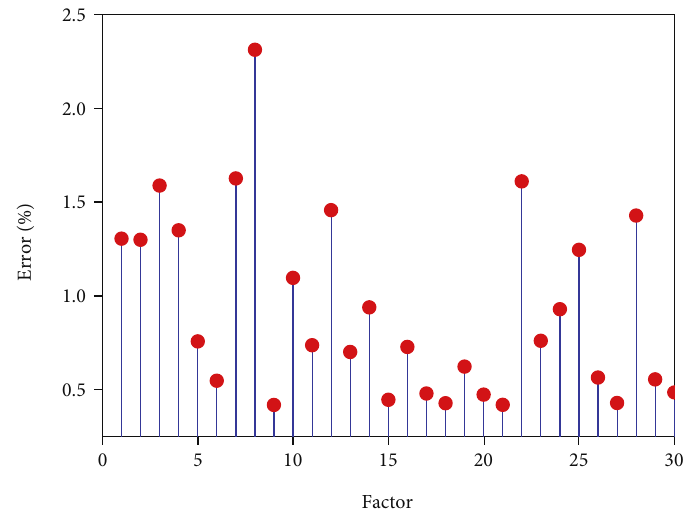
Figure 7: The scatter plot distribution of prediction error of student behavior characteristics in English teaching.